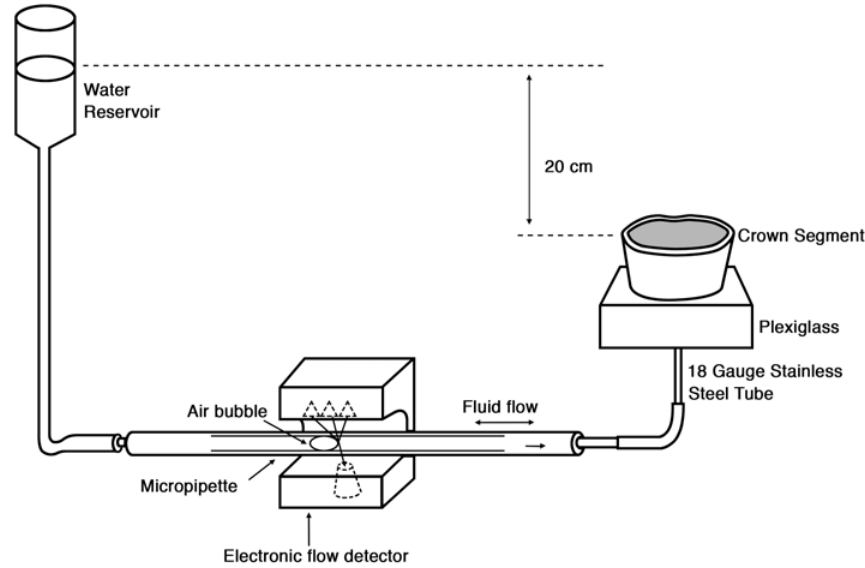
FIGURE 1- Schematic presentation of the fluid-filtration apparatus used to perform repeated measurements of the permeability of dentin surfaces after acid-etching and after